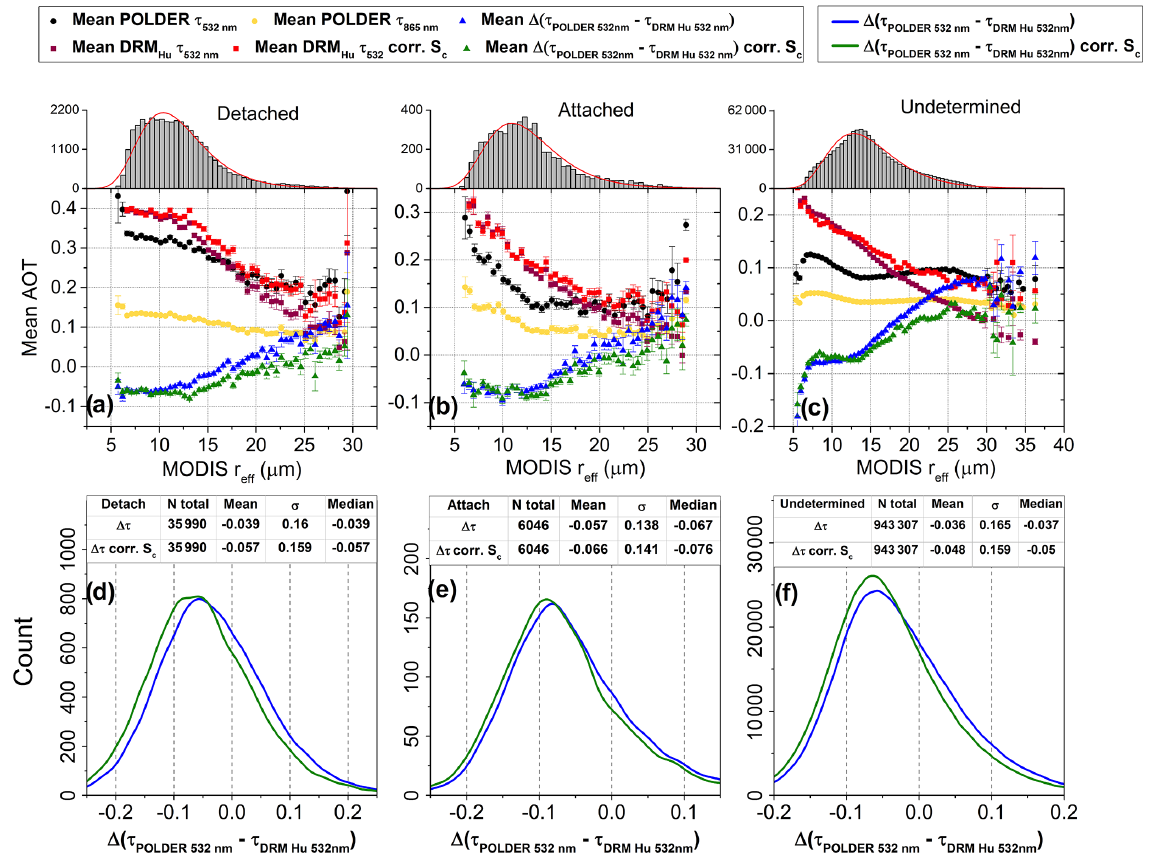
Figure 7. Same as Fig. 6: POLDER and DRM Hu above-cloud AOT retrievals as a function of MODIS effective radius ( r eff ,